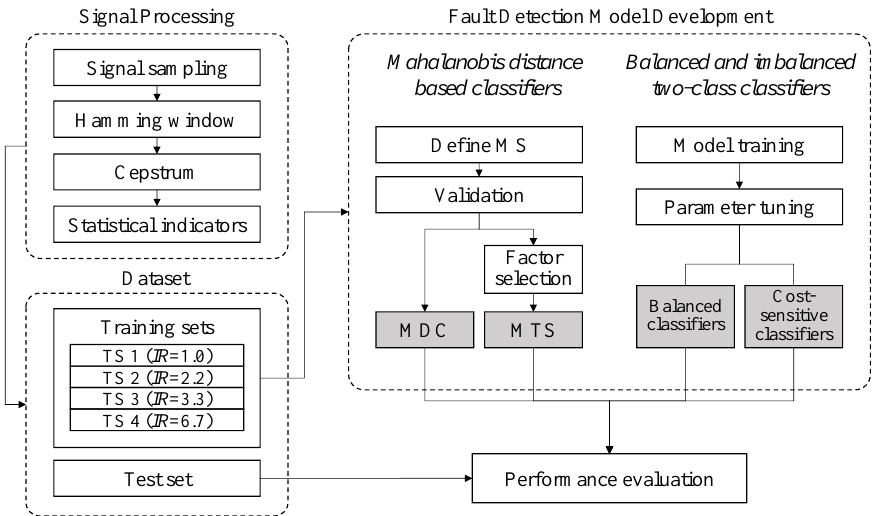
Figure 1. Procedure for fault-detection evaluation in this research.